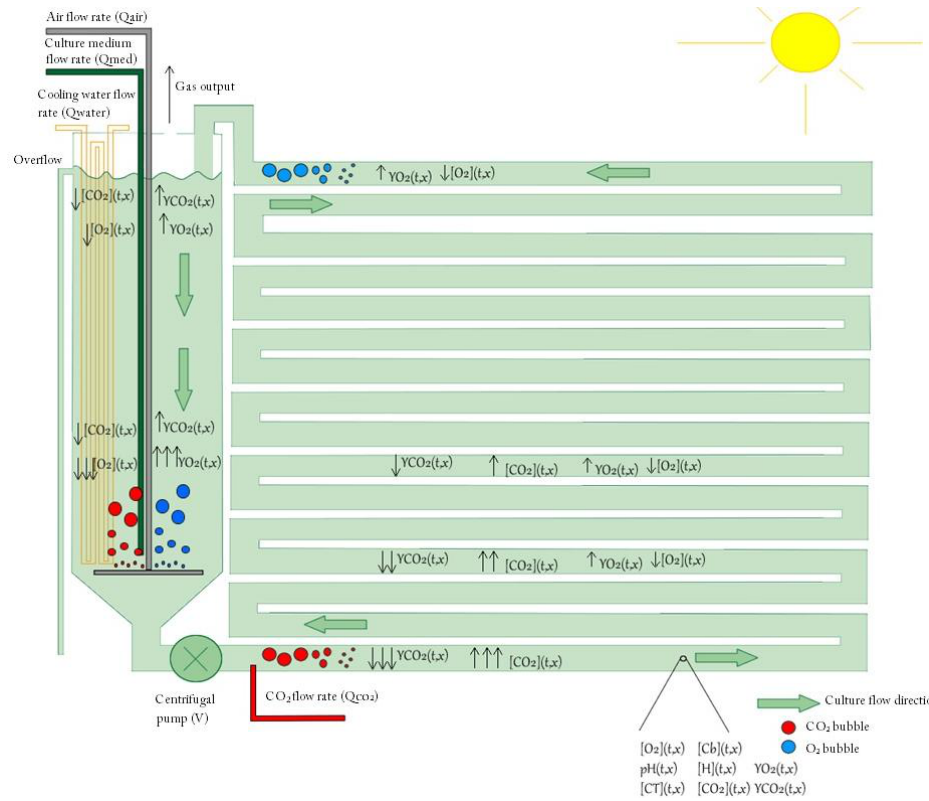
Figure A1. Schematic representation of the